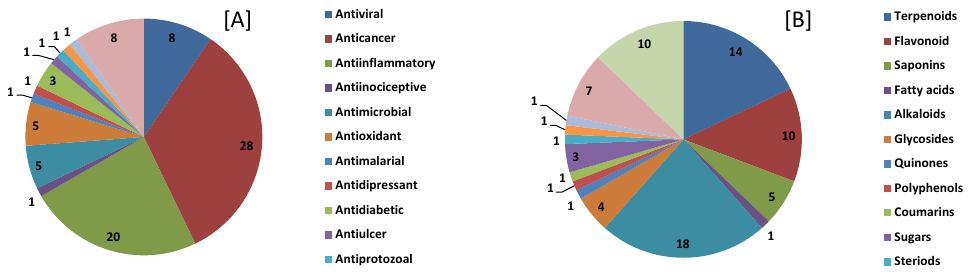
Figure 2. METLIN database matched compounds from Alangium salviifolium and grouped by therapeutic use ( A ) and compound class ( B ) based on literature reports.